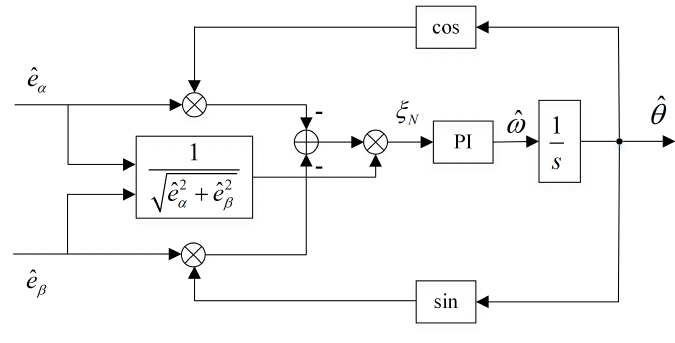
Figure 3. Angle-tracking observer.